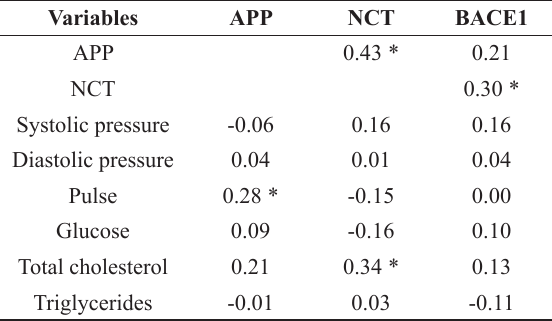
Correlation coefficients of the study